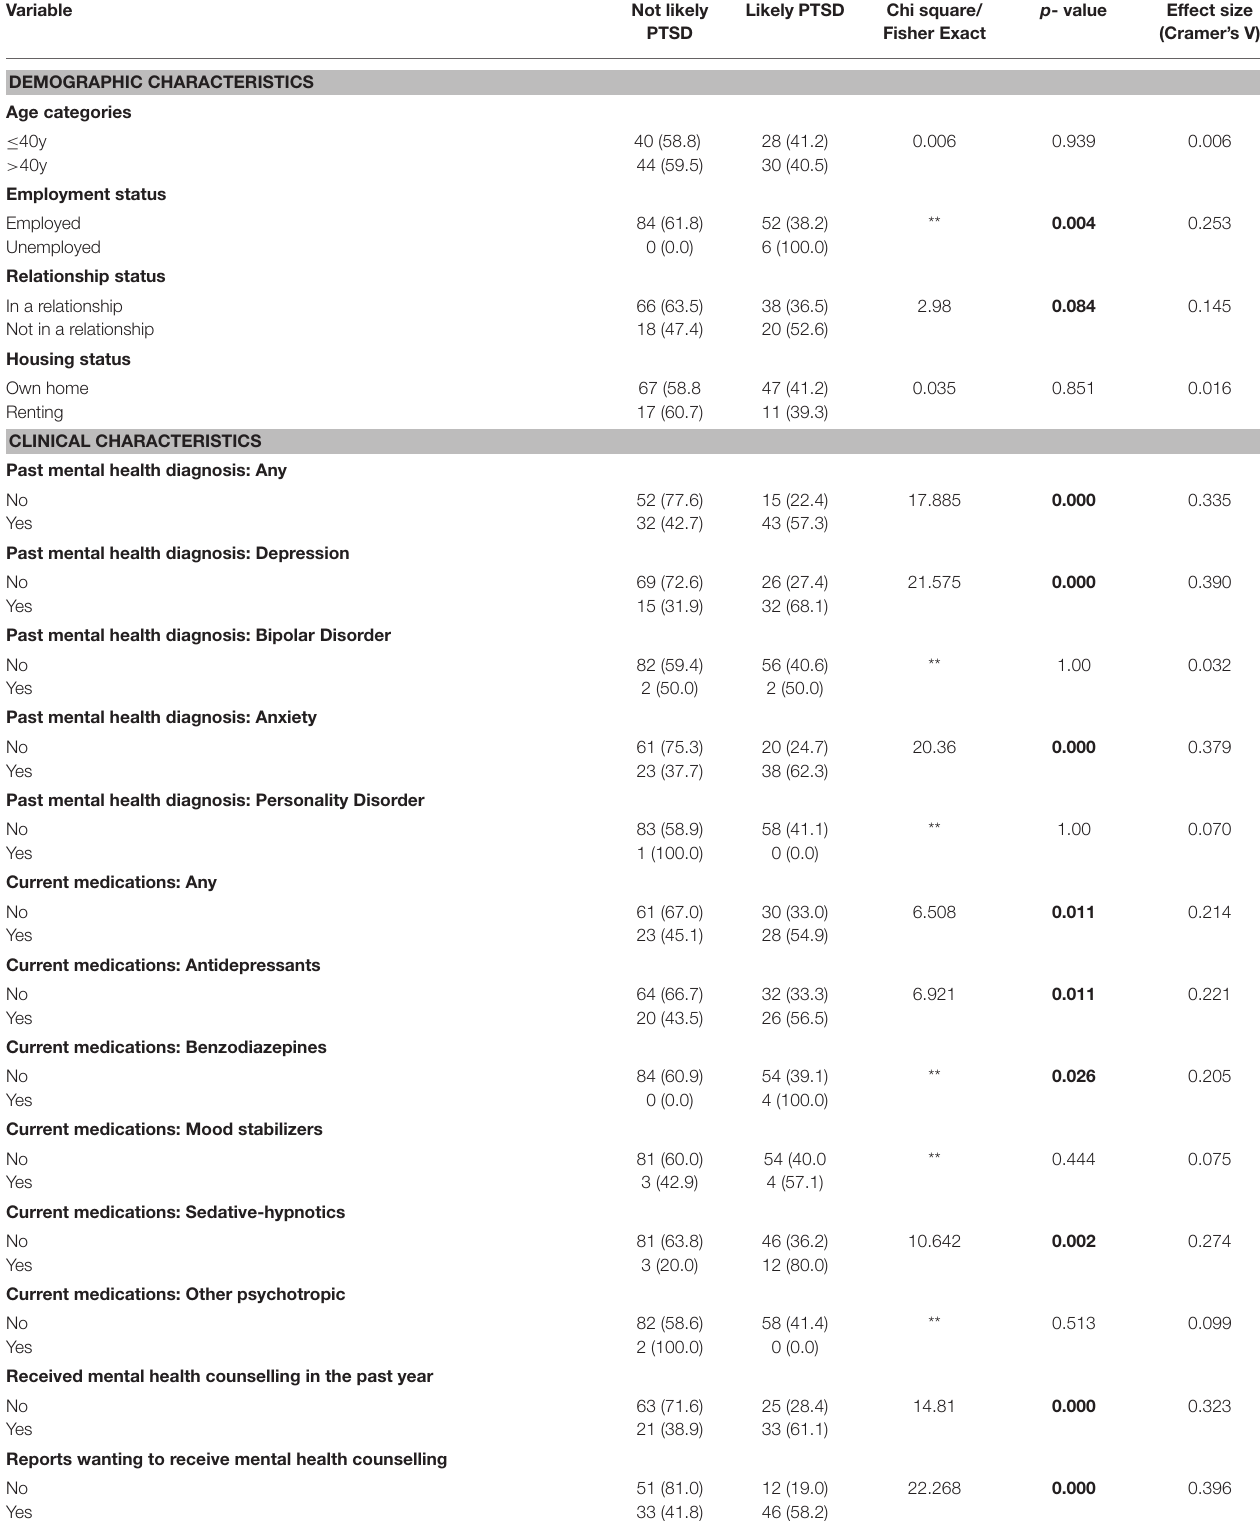
TABLE 2 | Chi square test of association between demographic variables, mental health status, COVID-19 characteristics, and probable PTSD.